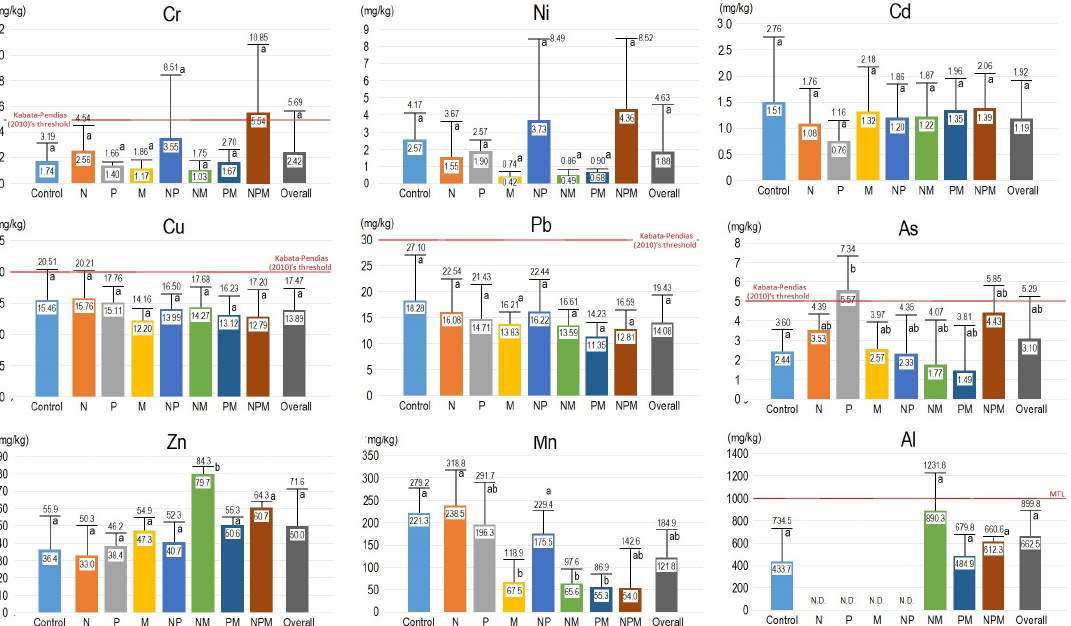
Figure 2. Metal levels of the above-ground biomass of bermudagrass under 25% sludge loading rate and different fertilization treatments in DG. (Note: N.D. = not determined due to insufficient amount of sample for analysis. Error bars indicate the 95% confidence interval. Different letters denote the statistical